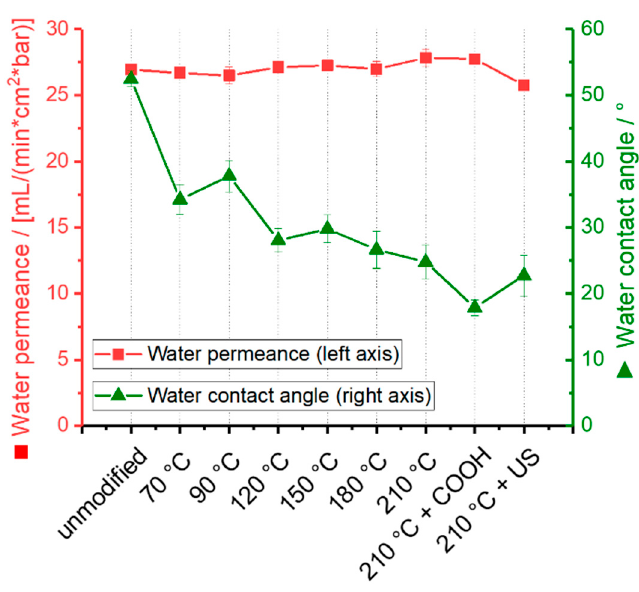
Figure 5. Water permeance (red, left ) and water contact angle (green, right ) of differently treated membranes (unmodified PES membrane, PES membrane with TiO 2 nanoparticles synthesized at different temperatures: 70 °C; 90 °C; 120 °C; 150 °C; 180 °C; 210 °C or modified with ultrasound: 210 °C + US, PES membrane modified with carboxyl groups prior to the dip-coating of TiO 2 nanoparticles: 210 °C + COOH.